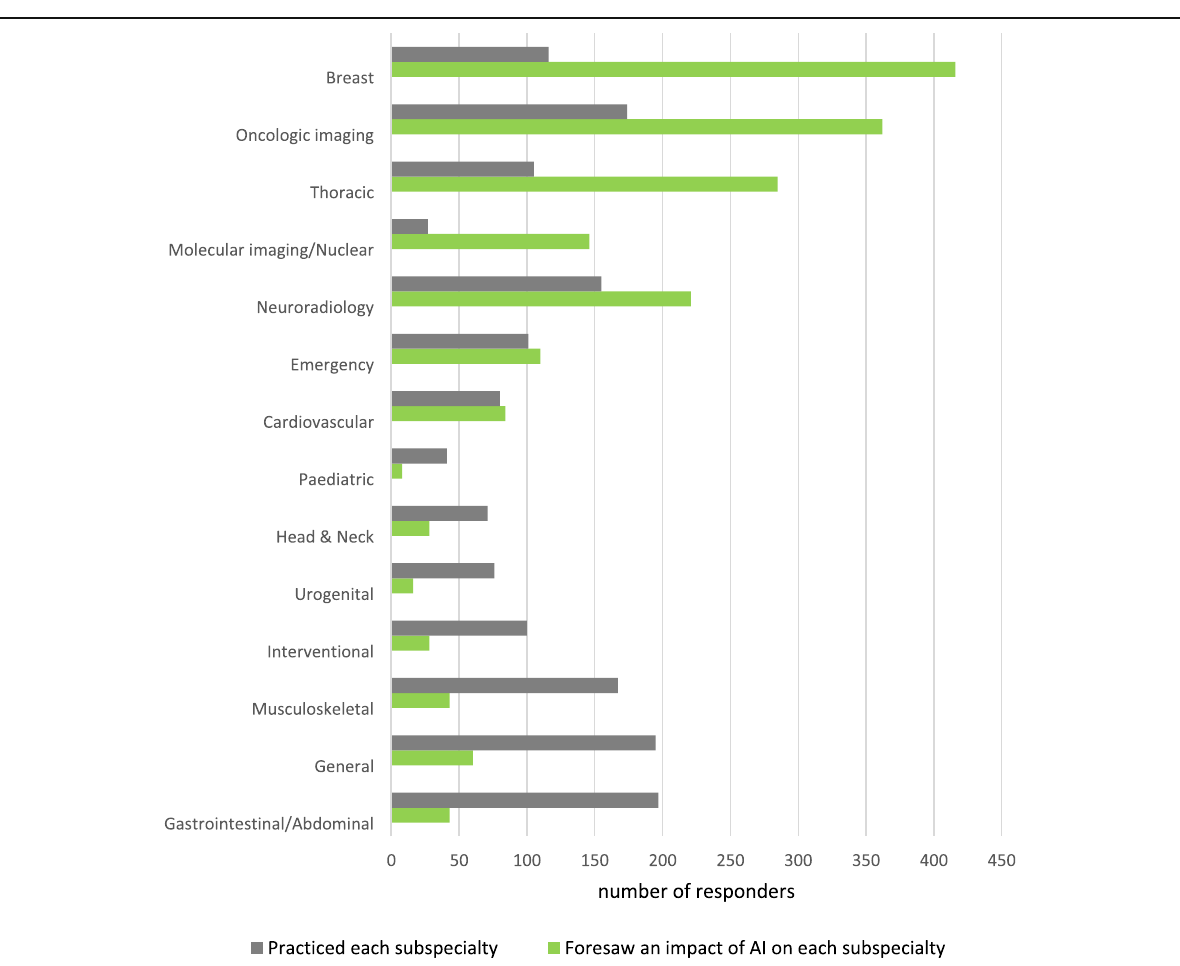
Fig. 3 Distribution of responders. The grey bars represent the number of responders that practice each subspecialty while the green bars represent those who foresaw an impact of AI on each subspecialty. Subspecialties are sorted according to the difference between values of green and grey